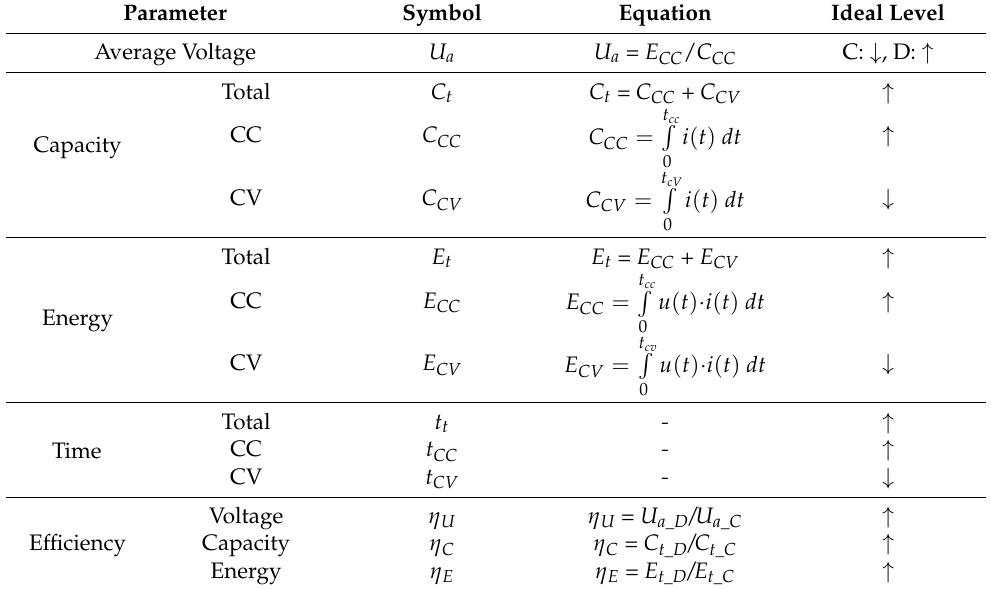
Table 3. Parameters derived from full